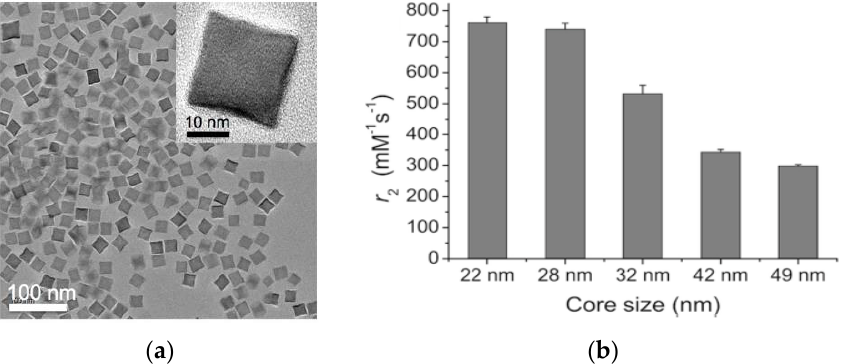
Figure 16. ( a ) TEM image of coated cubic SPIONs and ( b ) size dependent r2 relaxivity, reprinted with permission from [102] (ACS, 2012).